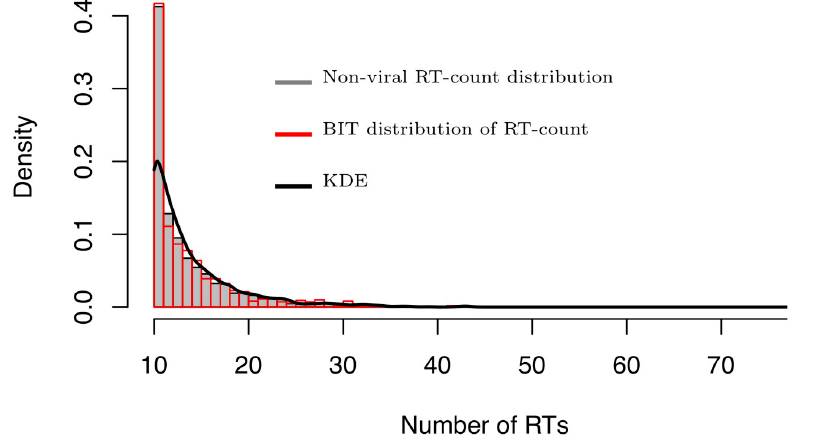
Fig 5. Retweet-count distribution of BIT and non-viral